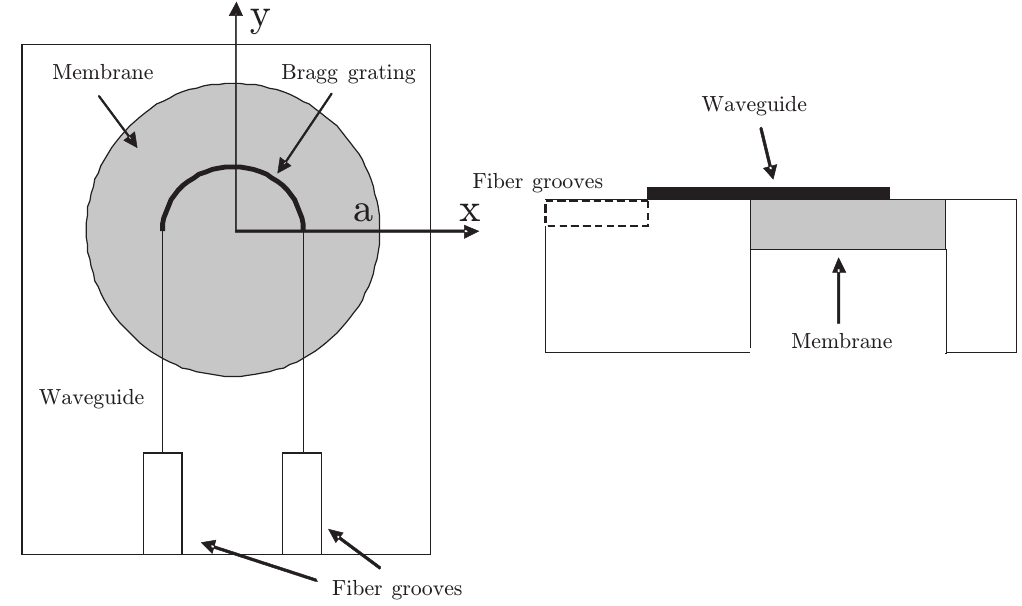
Figure 1. Top view (left) and side view (right) of the Bragg grating sensor. The sensor consists of a silicon membrane in a silicon chip with a dielectric optical waveguide on top; in the optical waveguide a Bragg grating is formed. The grating is located in the curved semicircular part of the waveguide on top of the membrane. The chip includes fiber alignment groves to facilitate coupling to optical